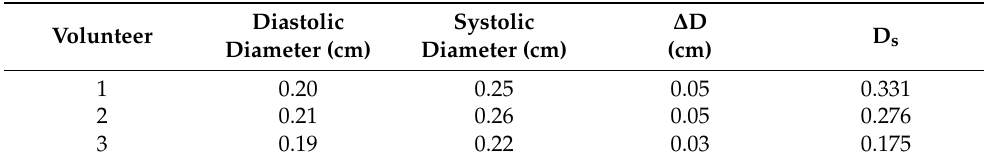
Table 1. Dynamic pulse width results for three